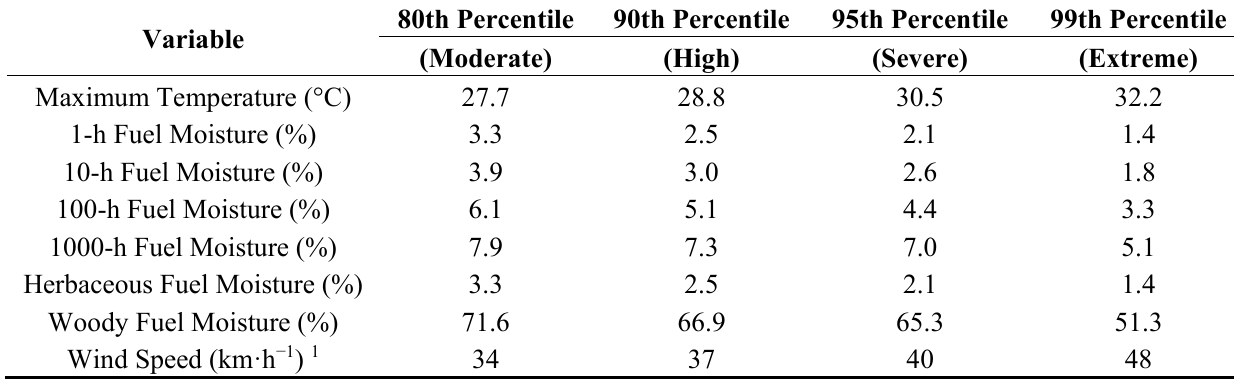
Table 2. Variables used for modeling four fire weather